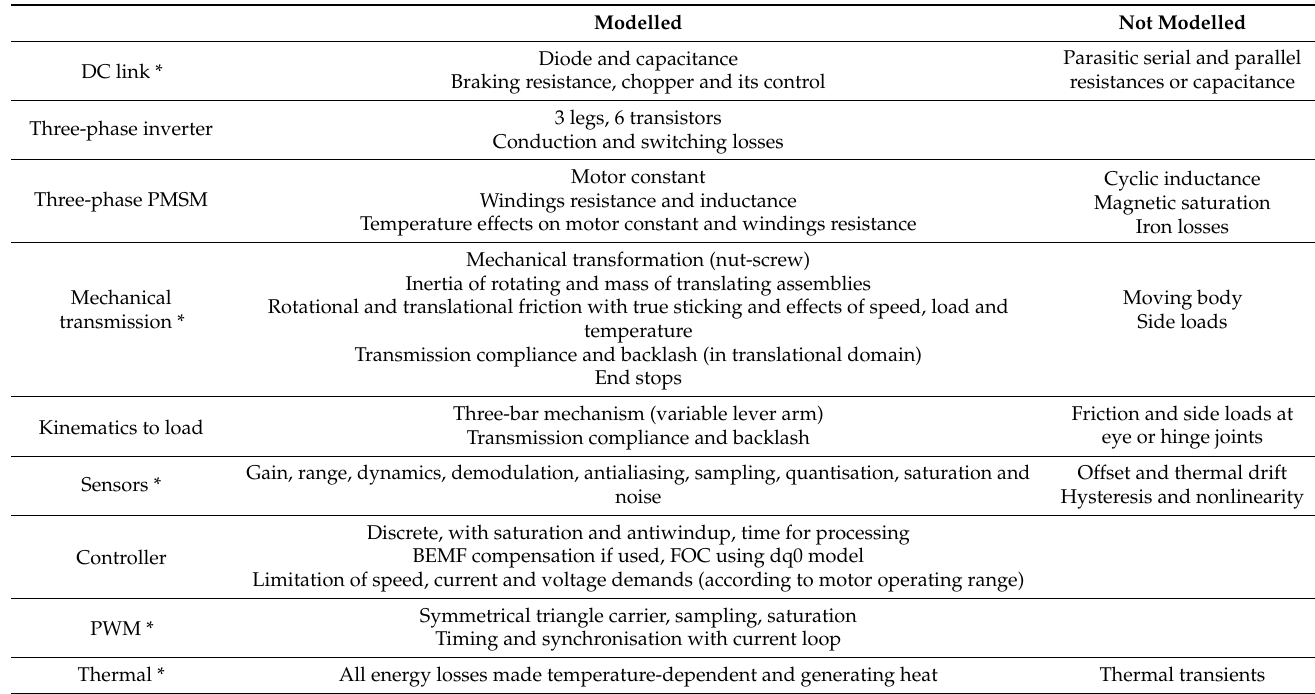
Table 1. Model used for the virtual validation of the controller